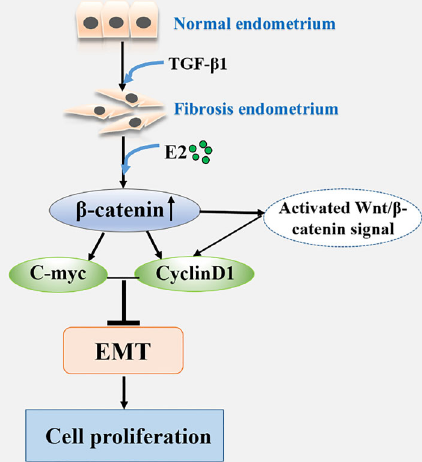
Figure 8. Schematic representation of Wnt/ b -catenin signaling involved in the regulation of the estrogen-inhibited epithelial- mesenchymal transition (EMT) process in fi brosis